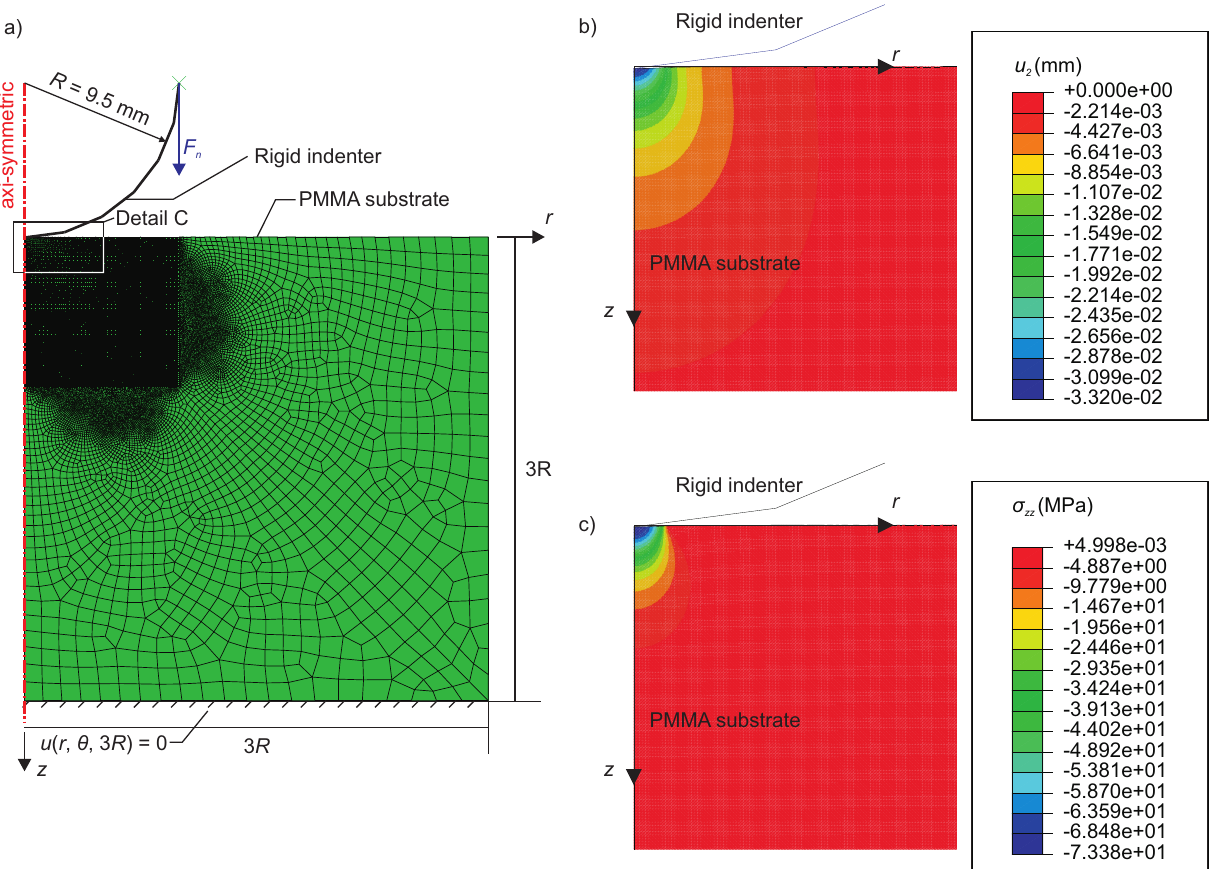
Figure 3. ( a ) Numerical model used to model the pressure distributions measured by the pressure-sensitive film; ( b ) displacements in the z -direction ( u ( σ ) from Detail C in (a). The results in (b) and (c) are for an applied normal force zz